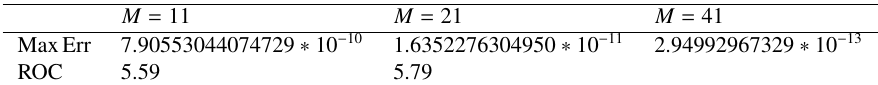
Table 1. Numerical results with the proposed method for Example 1. M = 11 M = 21 M =